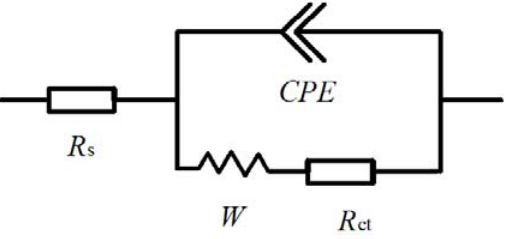
Scheme I. Equivalent circuit for Nyquist plots. R , electron-transfer resistance; W , Warburg element due to diffusion of phase element; R ct